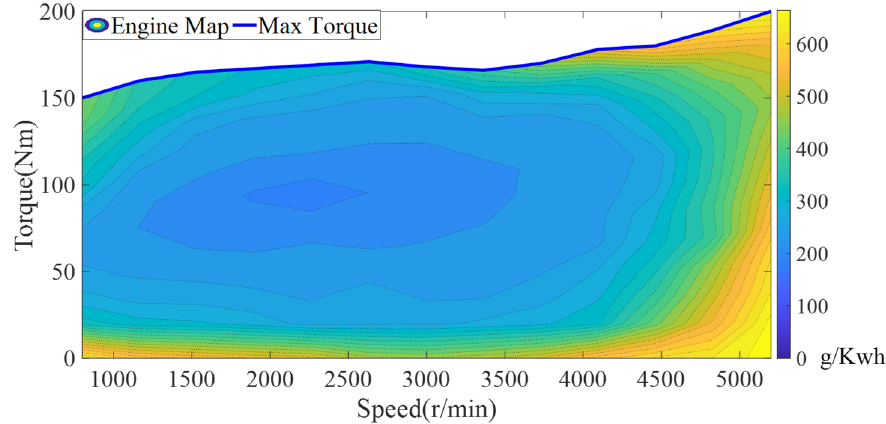
Figure 2. The fuel consumption map of the engine.